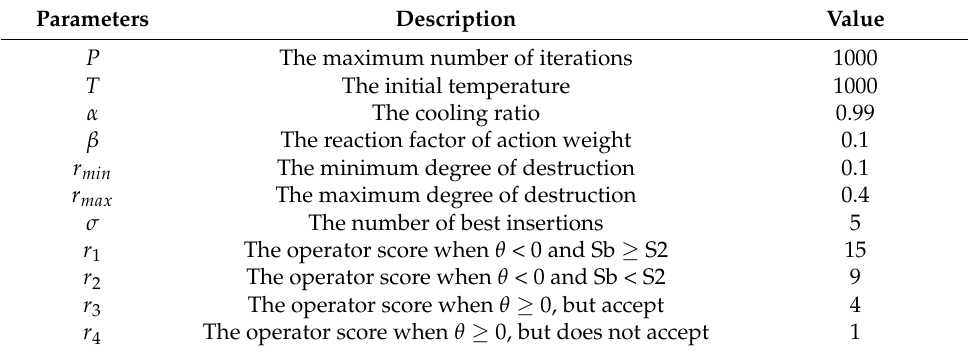
Table 3. The relevant parameters of